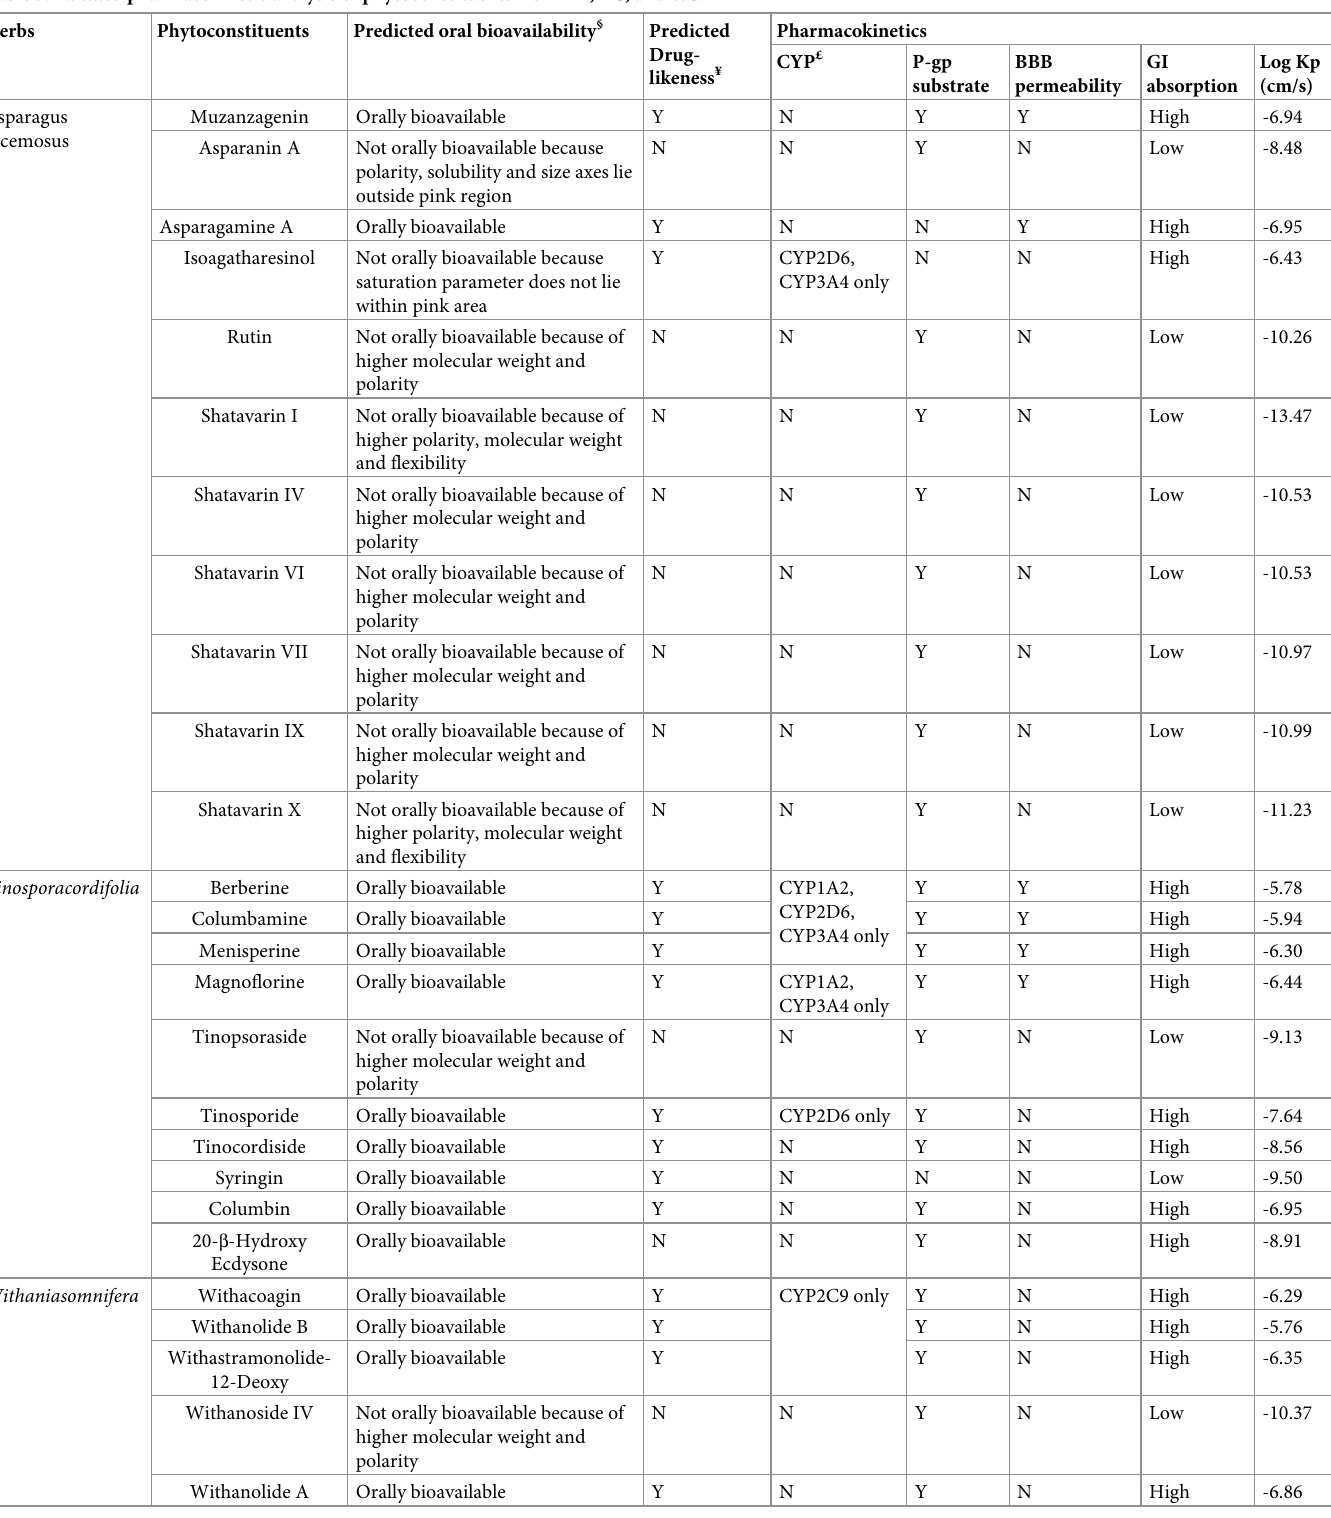
Table 3. In silico pharmacokinetic analysis of phytoconstituents from AR, TC, and WS. Herbs Phytoconstituents